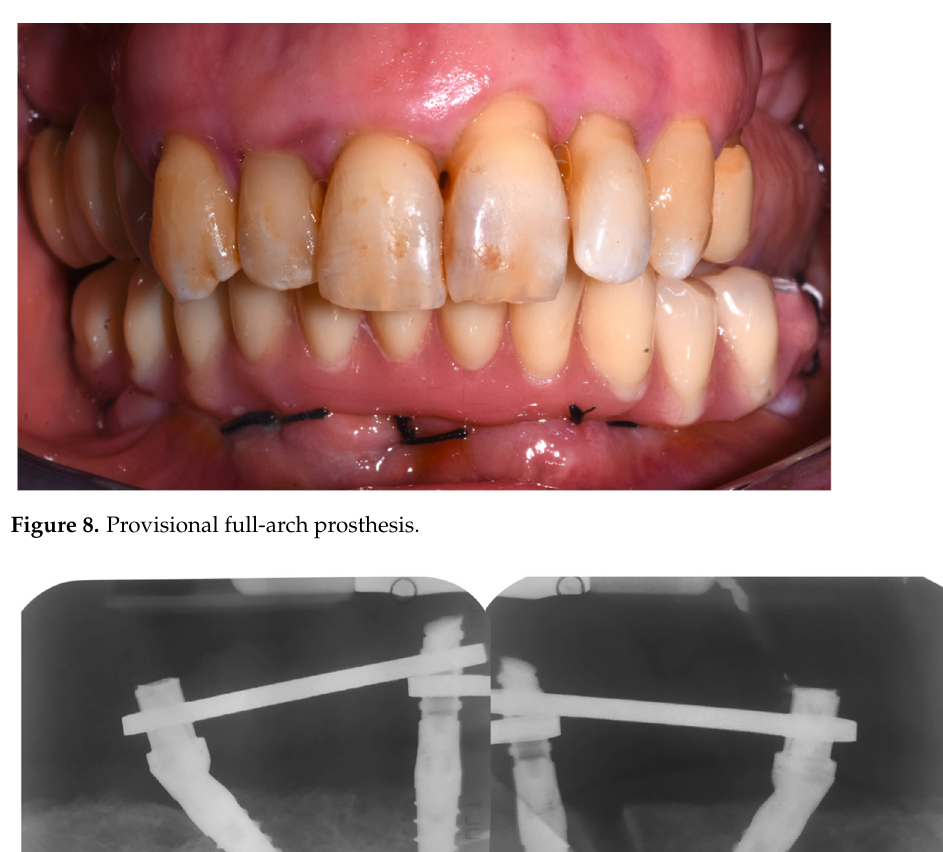
Figure 9. Implant X-rays immediately after load. The soft-tissue healing at 48 h after surgery is shown in Figure 10.